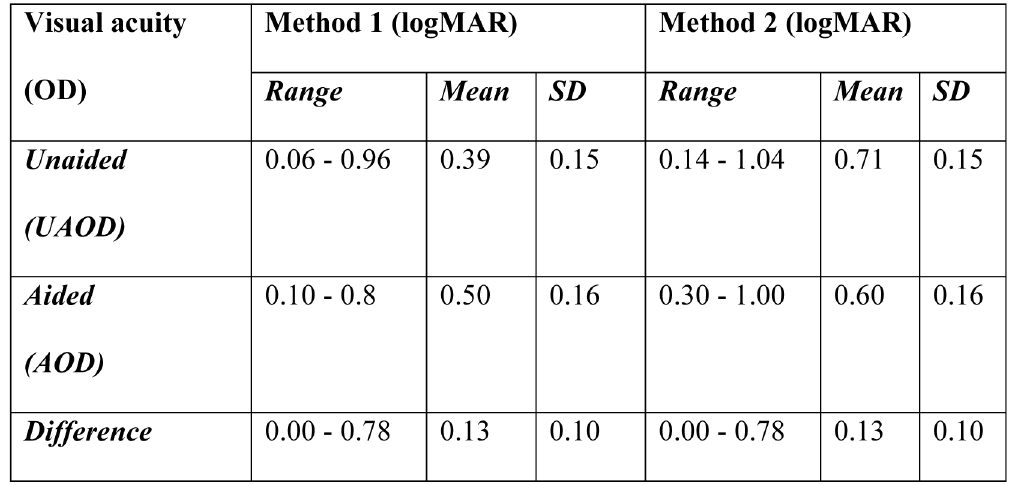
Table 2: Showing the ranges, means and SD for the logMAR VA values for all subjects. The analysis of the differences in VA between the unaided and aided (unaided minus aided) for method (DOD1) and method 2 (DOD2) are presented as ‘difference’ in the table. The range, mean and SD of differences of the methods were the